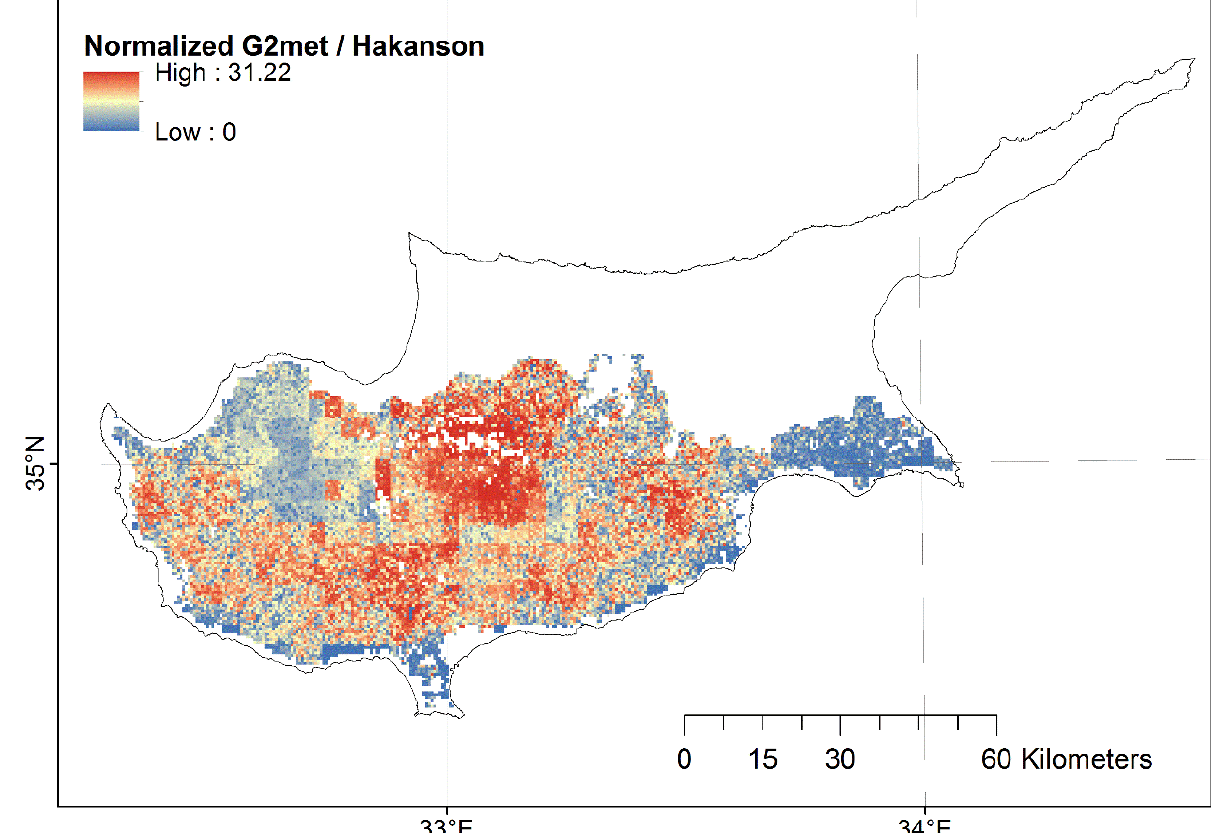
Figure 7. The layer of ratio between normalized (with the mean) layers of annual G2 met total risk and Hakanson index (cell size: 500 m; value ranging: histogram equalization; mean value =